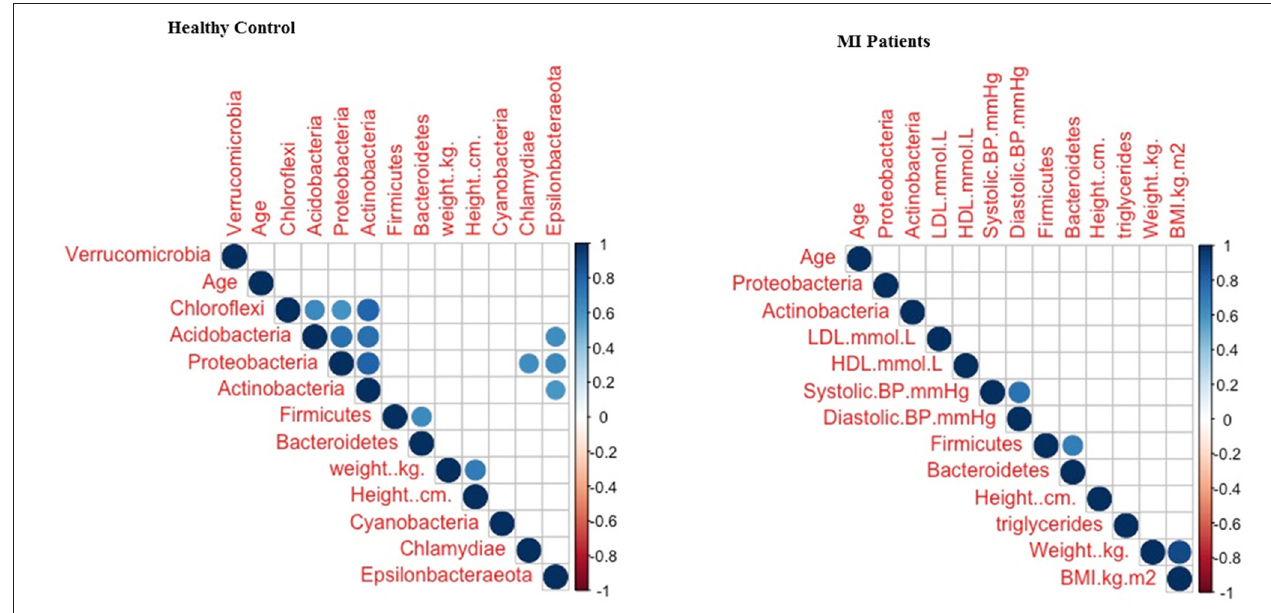
FIGURE 6 | The correlation between clinical parameters and blood bacterial